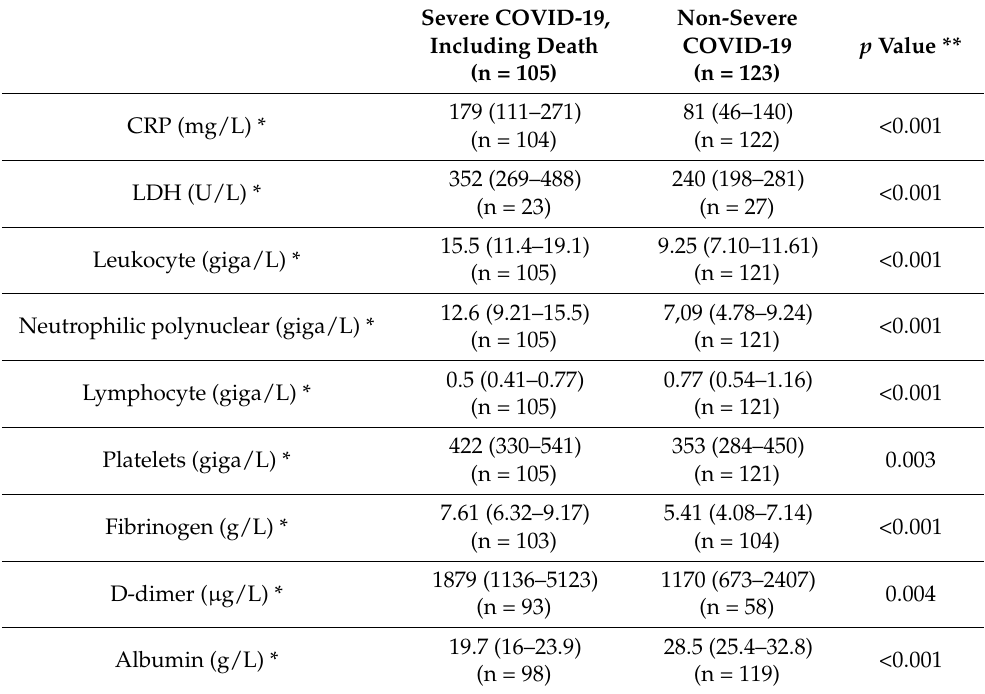
Table 2. Biomarkers related to COVID-19